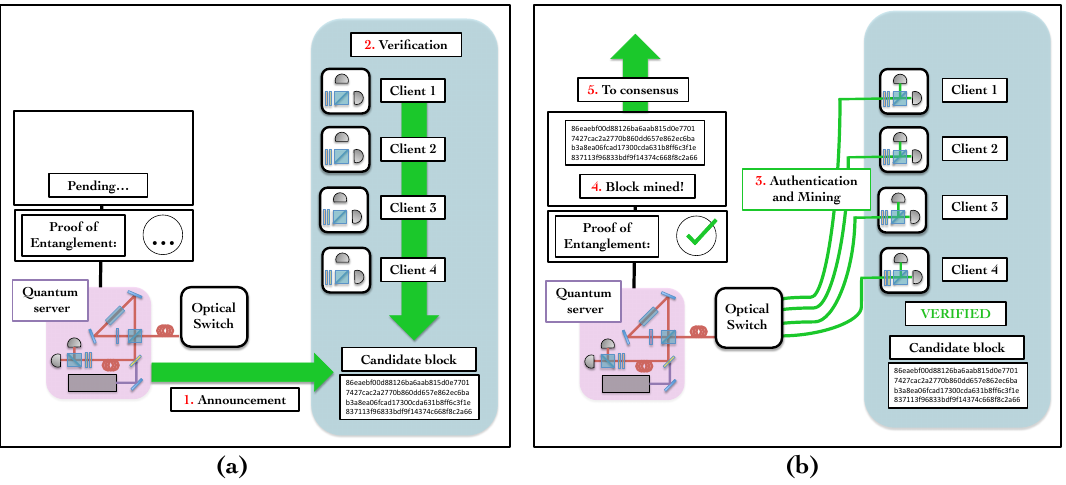
Fig. 1. Overview of the mining protocol on a quantum-enabled consortium